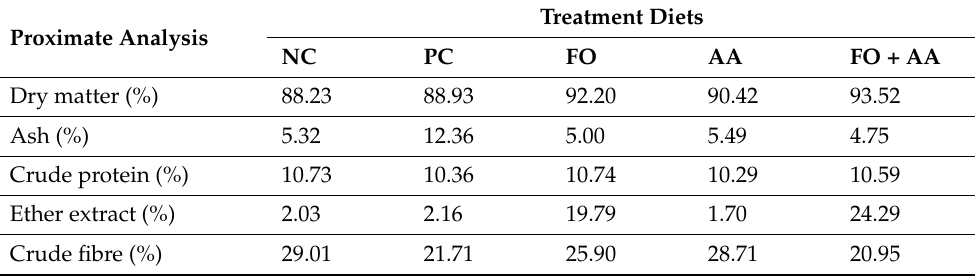
Table 1. Proximate analysis of treatment